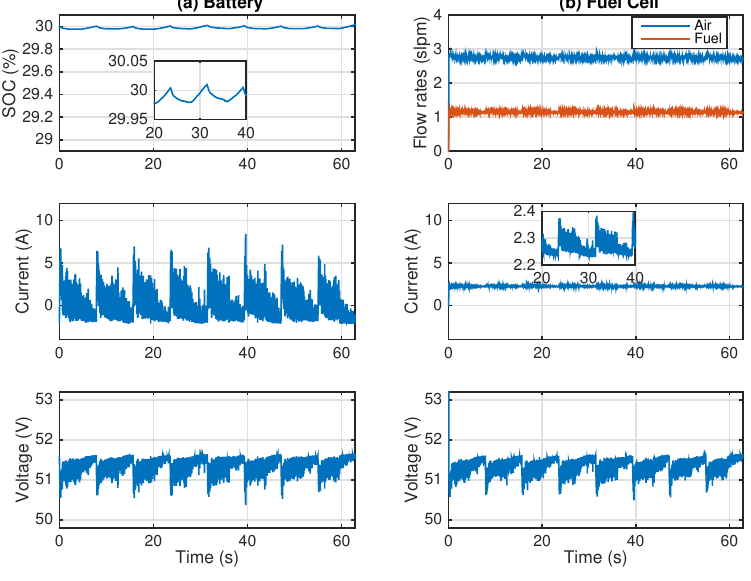
Figure 15. Low-SOC passive hybrid simulation. ( a ) Battery response, ( b ) FC response.